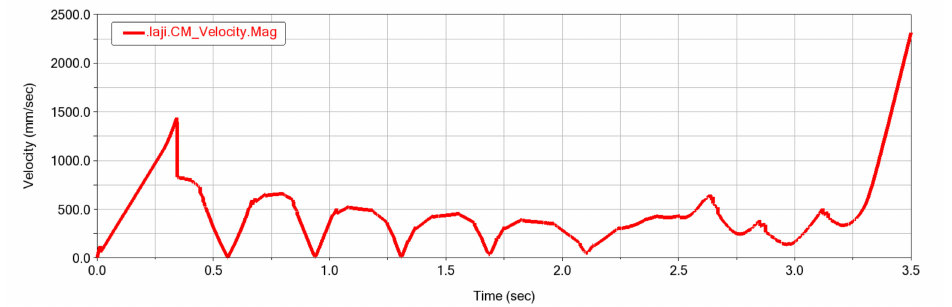
Figure 15. Waste velocity curve. The x-axis represents time, and the y-axis denotes the size of the garbage combined velocity.